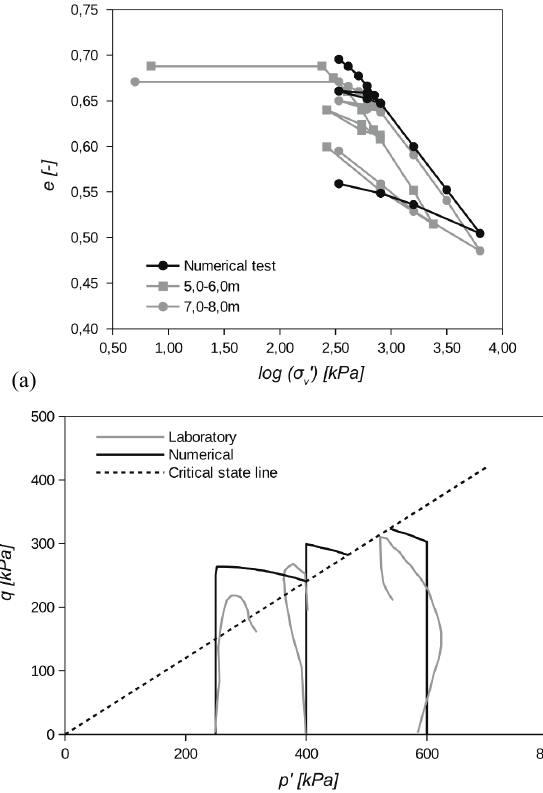
Fig. 3. Calibration of geotechnical